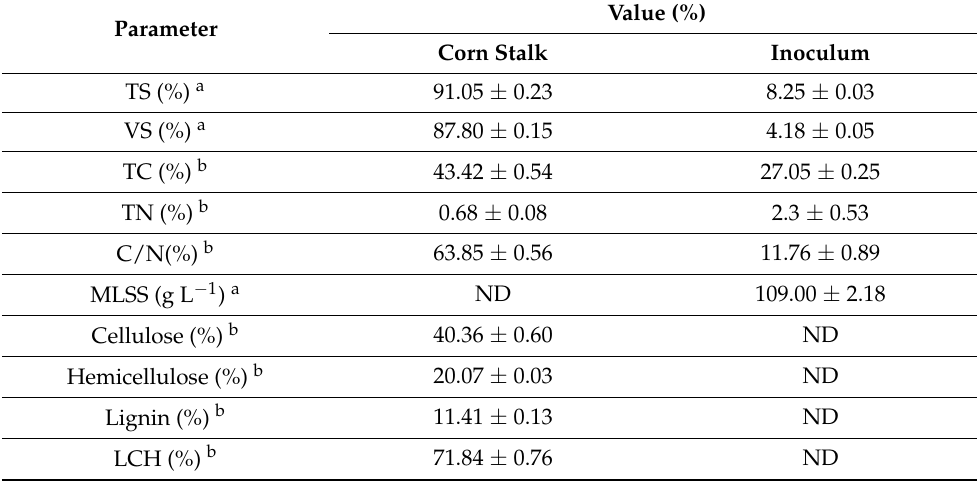
Table 1. Characteristics of corn stalk and inoculum before incubation